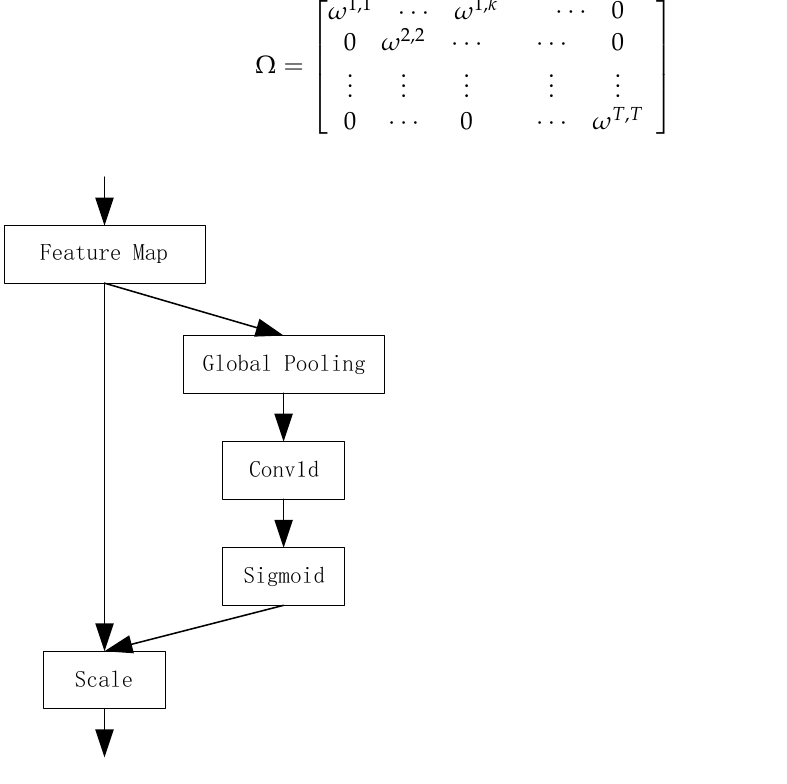
Figure 5. ECA network structure diagram.